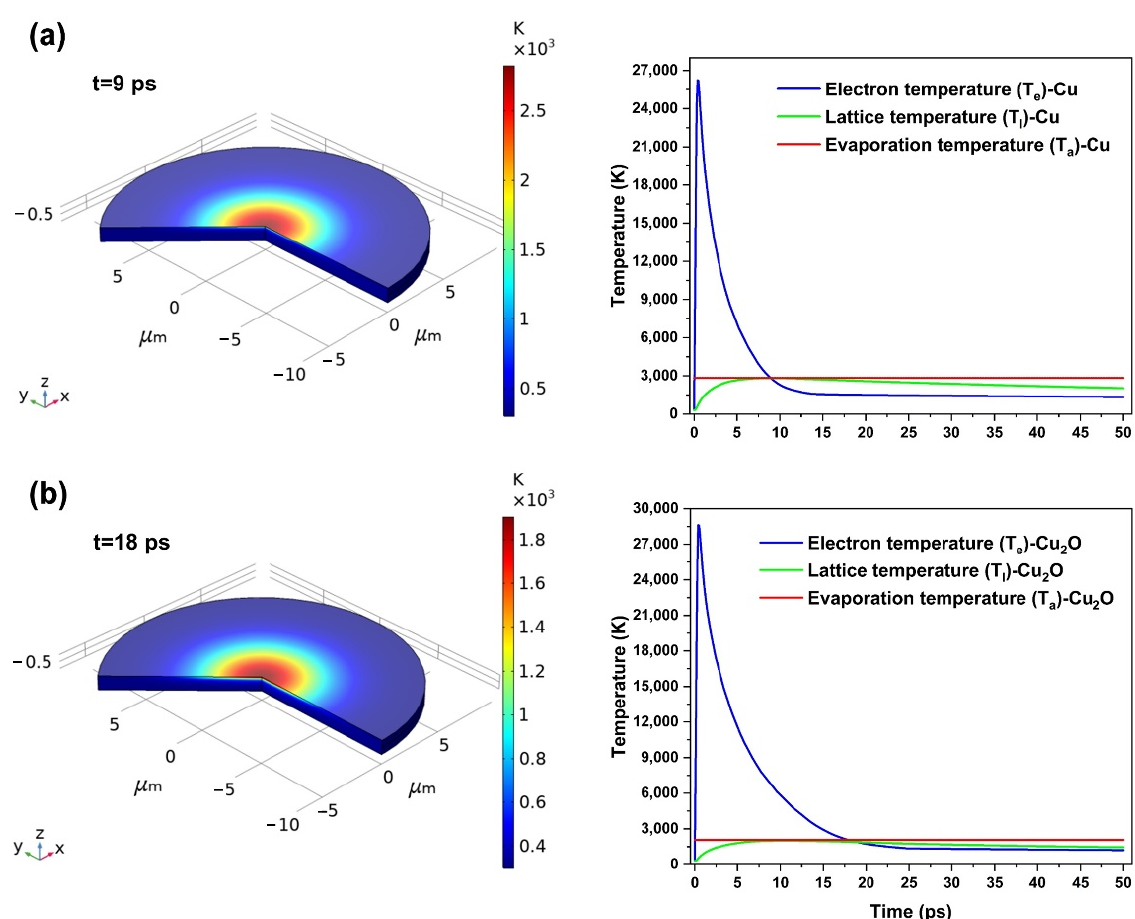
Figure 2. The distribution of lattice temperature and the evolution of electrons and lattice temperature as a function of time during the irradiation in the single pulse: ( a ) Cu and ( b ) Cu 2 O.